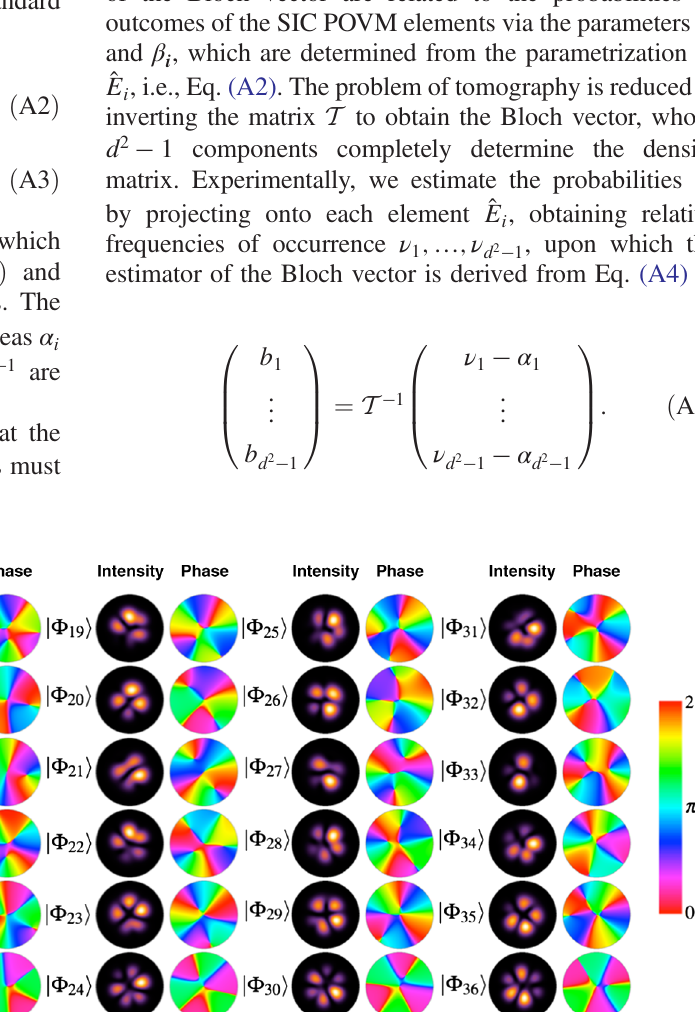
FIG. 6. Intensity and phase of SIC POVM elements for photonic qudit state of dimension six. The states are calculated by acting 36 Weyl-Heisenberg operators represented in Eq. (3) on the fiducial state of j f 6 i . The implemented OAM Hilbert space spans on fj þ 3 i ; j þ 2 i ; j þ 1 i ; j − 1 i ; j − 2 i ; j − 3 ig OAM